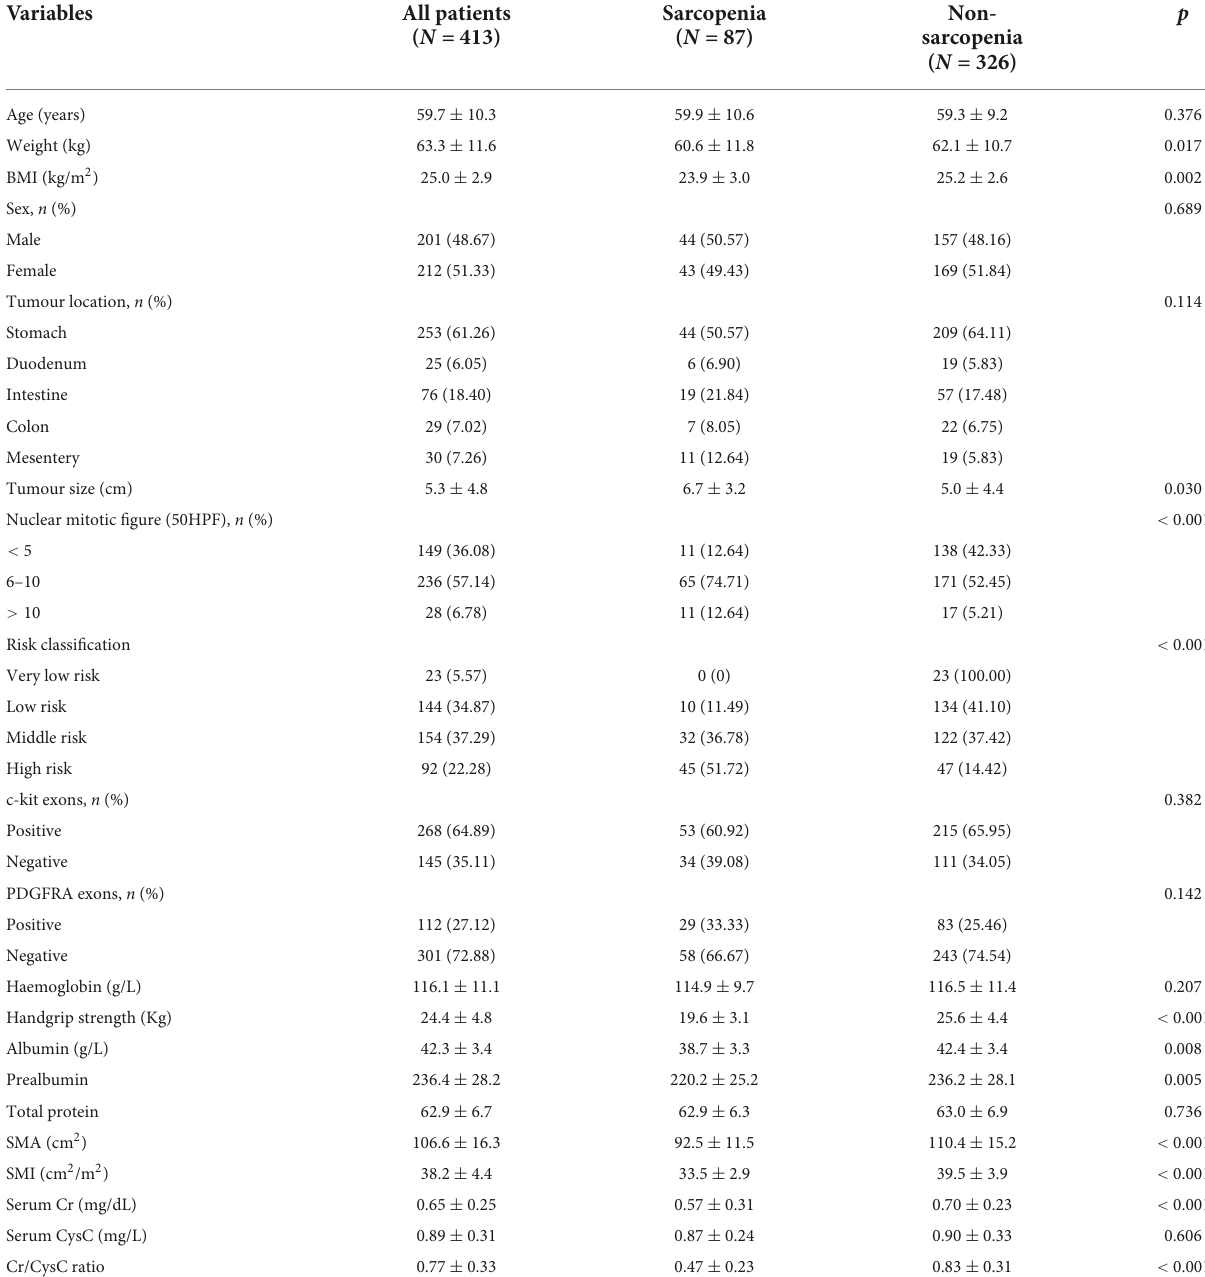
TABLE 1 Characteristics of patients included in the